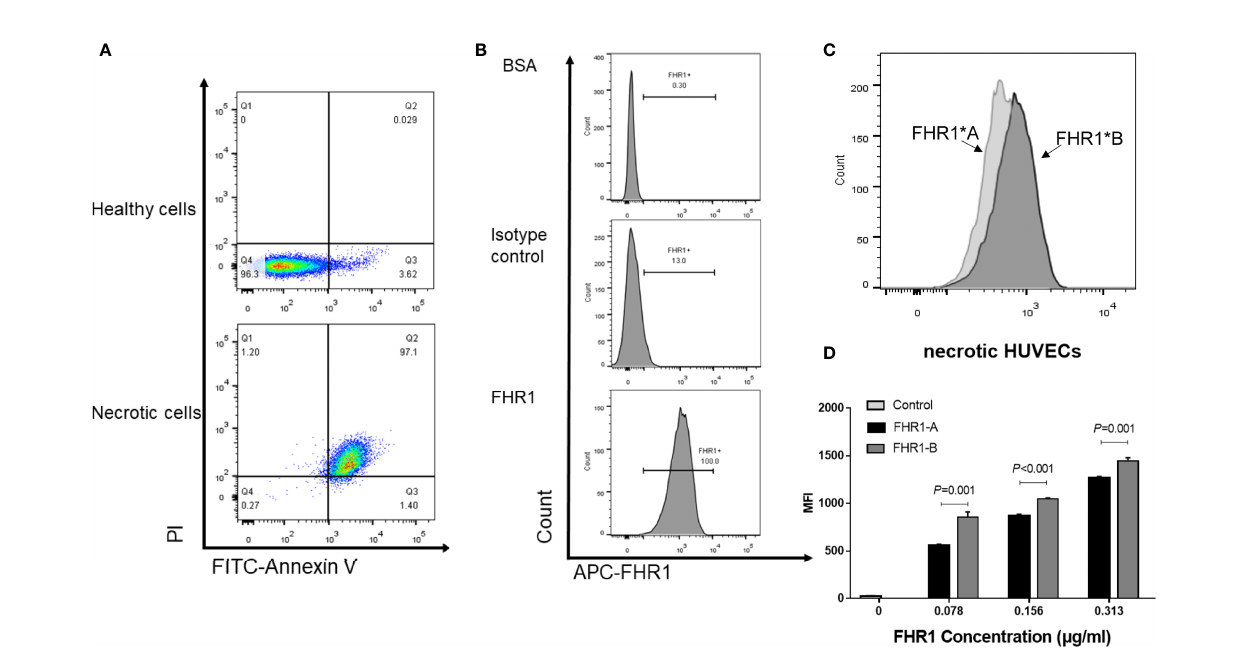
FIGURE 3 | Binding of the FHR1 isoforms to necrotic cells. Necrosis cells was evaluated by PI and Annexin V staining. Double positive for both Annexin V and PI cells were considered as necrotic cells (A) . The representative fi gures for blank control, isotype control and sample incubated with FHR1 protein were showed (B) . FHR1 proteins (0.078 m g/ml-0.313 m g/ml) bound to necrotic HUVECs in a dose-dependent manner. The representative fi gures for samples incubated with both FHR1*A and FHR1*B protein were showed (C) . In addition, compared to FHR1*A, FHR1*B presented signi fi cantly increased capacity to bind to necrotic HUVECs at concentrations between 0.078 m g/ml and 0.313 m g/ml (D) . The results are representative of three independent experiments. The data are presented as the means ± SDs. MFI, Mean fl uorescence